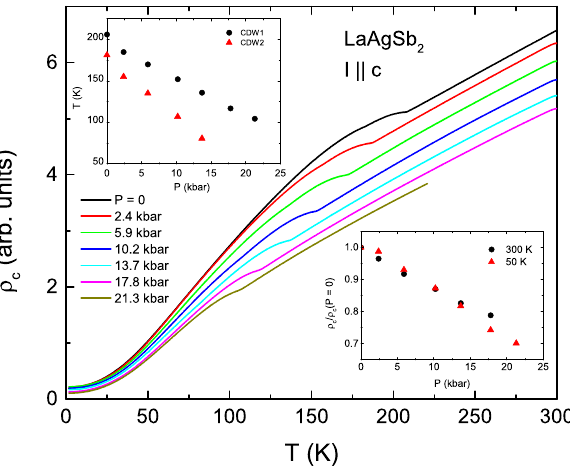
Figure 7. Temperature-dependent c -axis resistivity of LaAgSb 2 measured at different applied pres- sures. Upper inset: CDW transition temperatures, T CDW 1 and T CDW 2 , as a function of pressure. Lower inset: normalized resistivity at 300 K and 50 K as a function of